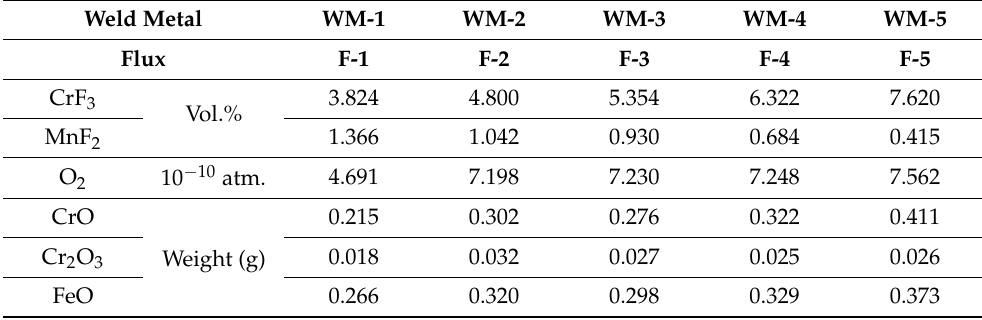
Table A3. Parts of the gas-slag-metal equilibrium calculation outputs under 1973 K for 100 g WM. Weld Metal